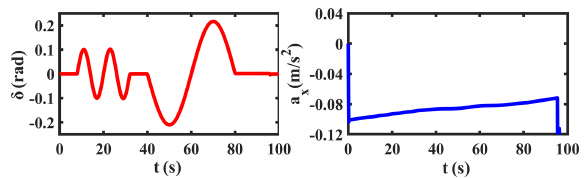
Figure 5. The results of δ and a x under the sine manoeuver test.